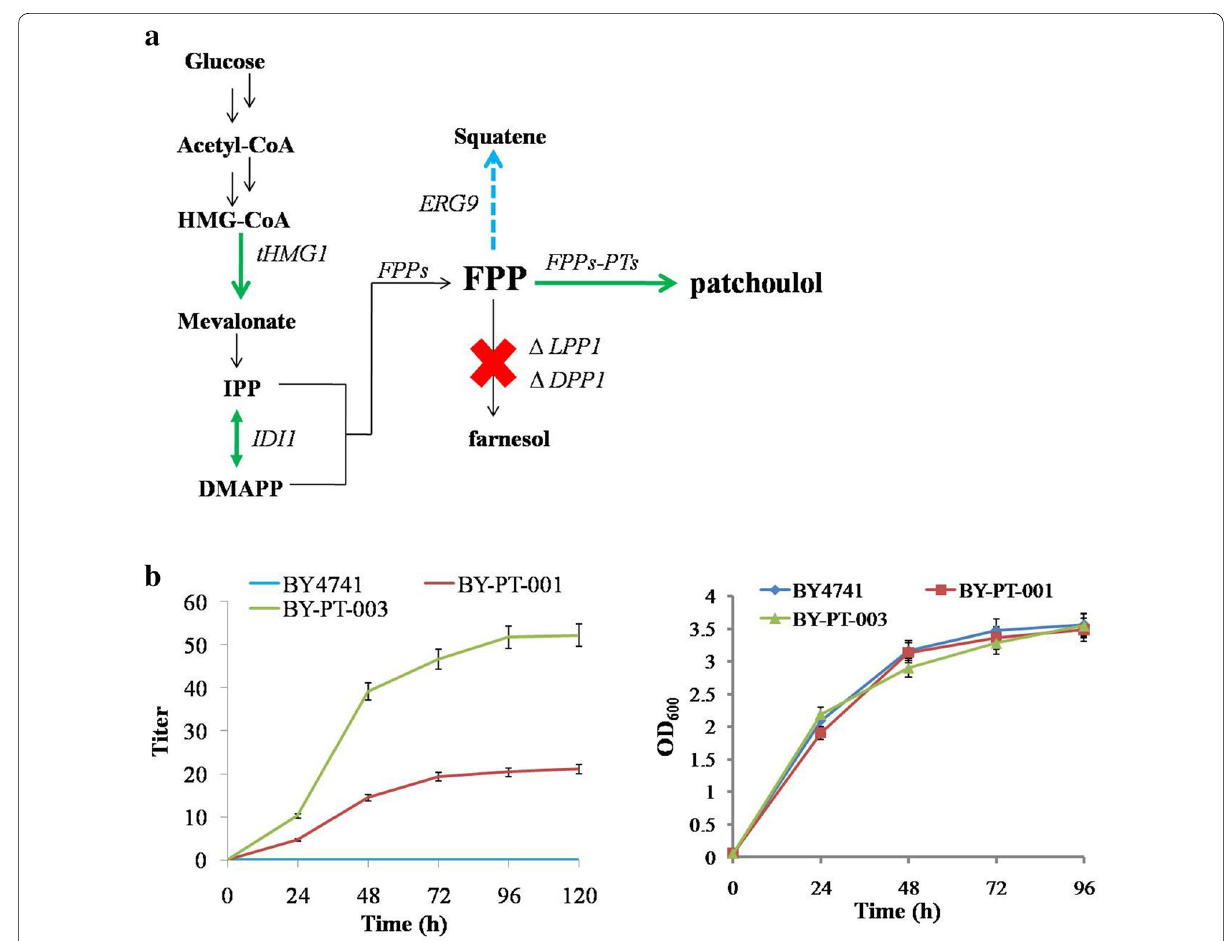
Fig. 5 Application of scCRISPR/Cpf1 in metabolic pathway engineering. a Construction and optimization of the synthesis pathway of patchoulol in S. cerevisiae. Black single arrows represent one‑step conversions. Black double arrows represent multiple steps. Green arrows represent the overexpressed genes. Blue arrow represents the downregulated gene by P HXT1 promoter. Red cross represents the deleted gene. HMG‑CoA, 3‑hydroxy‑3‑methylglutaryl coenzyme A; IPP, isopentenyl pyrophosphate; DMAPP, dimethylallyl pyrophosphate; IDI1 , isopentenyl pyrophosphate isomerase; FPP, farnesyl diphosphate; tHMG1 , truncated 3‑hydroxy‑3‑methylglutaryl‑coenzyme‑A reductase; ERG9 , squalene synthase; LPP1 and DPP1 , both encoding lipid phosphate phosphatases; FPPs : farnesyl diphosphate synthase; and FPPs ‑ PTs , fusion gene of farnesyl diphosphate synthase and patchoulol synthase. b (Left) The patchoulol titer produced at various time points in strains BY4741, BY‑PT‑001, and BY‑PT‑003, respectively. (Right) The growth curves of strains BY4741, BY‑PT‑001, and BY‑PT‑003,